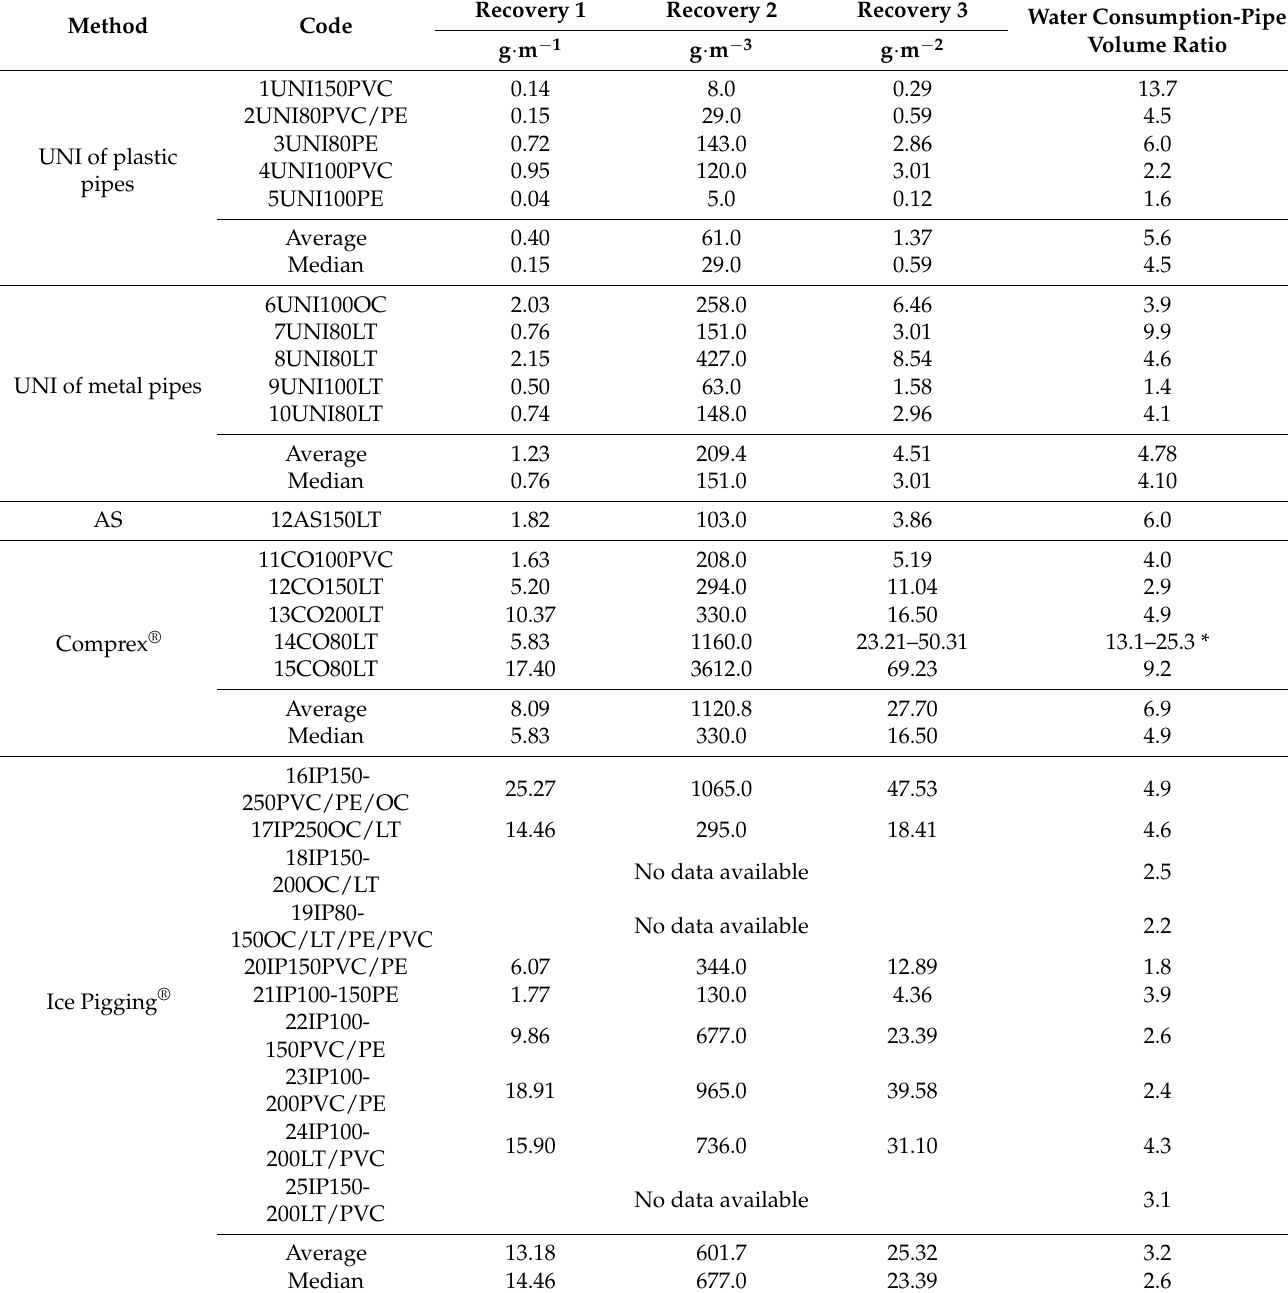
Table 3. Summary of total sediments recovery as TSS per unit length, unit volume and unit area and water consumption of tested methods including average and median. (UNI—Unidirectional flushing; AS—Air scouring; Recovery 1—Total TSS calculated per length of the pipe; Recovery 2—Total TSS calculated per the inner volume of the pipe; Recovery 3—Total TSS calculated per the inner area of the pipe; * estimated water